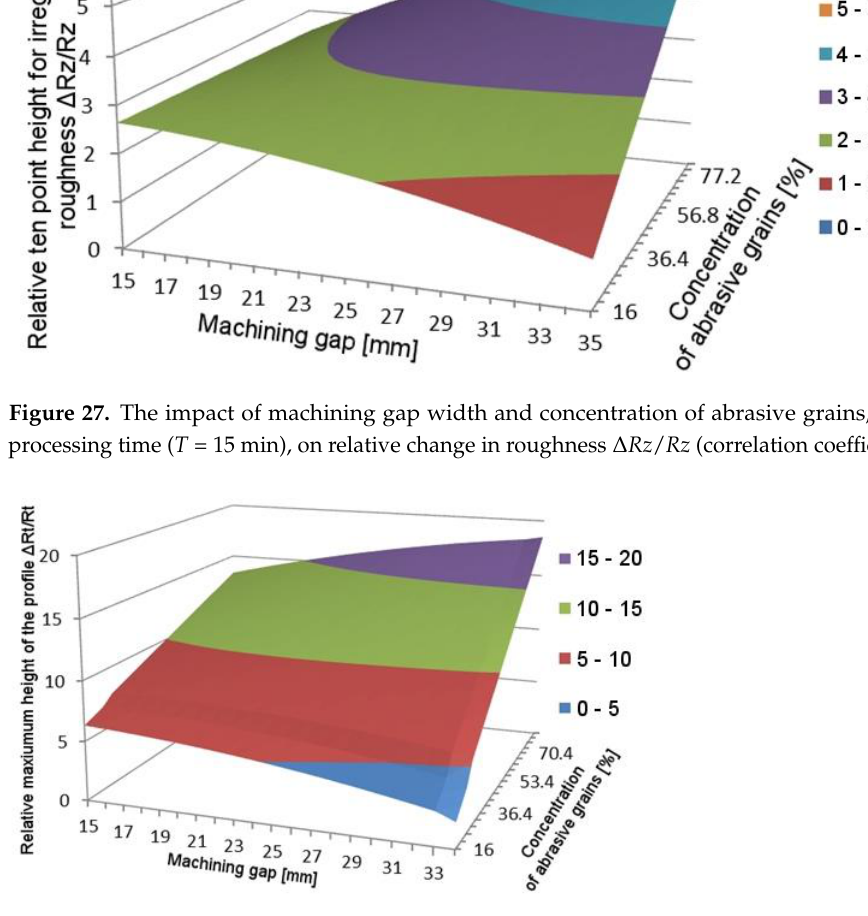
Figure 28. The impact of machining gap width and concentration of abrasive grains, at constant processing time ( T = 15 min), on relative change in roughness ∆ Rt / Rt (correlation coefficient R = 0.57).